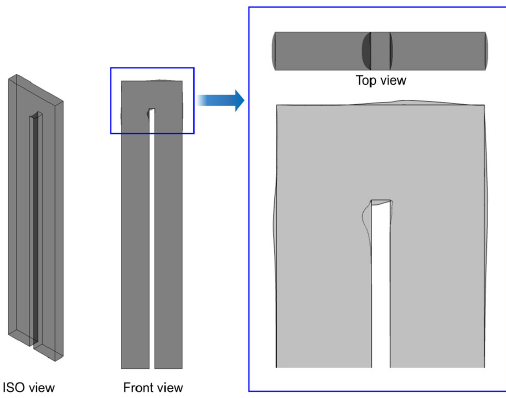
Figure 14. Geometric shape changes using the adjoint solver (Re =